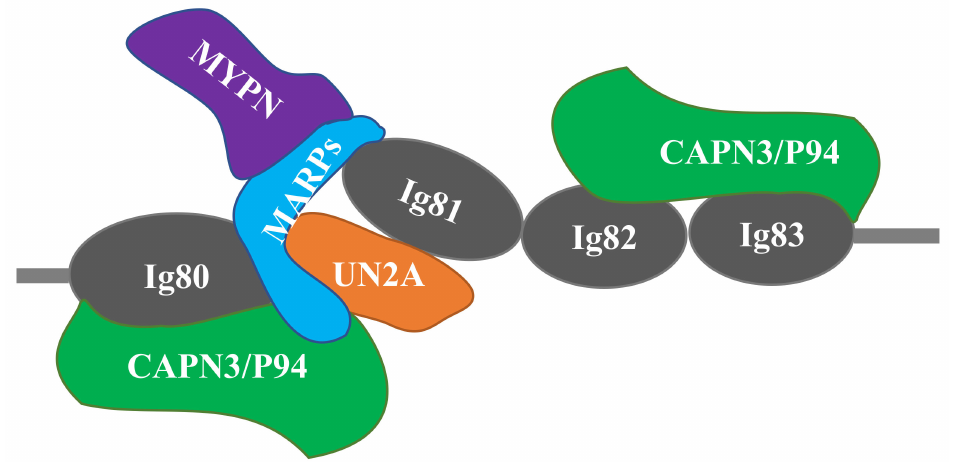
Figure 2. Schematic of the titin-N2A signaling complex. MARP1 and 2 bind competitively to N2A titin’s unique sequence (UNA), located between Ig80 and Ig81. CAPN3 binding is localized to both Ig80 / UN2A and Ig82 / Ig83. Myopalladin (MYPN) associates with the N-terminal domains of MARPs. Adapted from Miller et al. [41] and Hayashi et al.